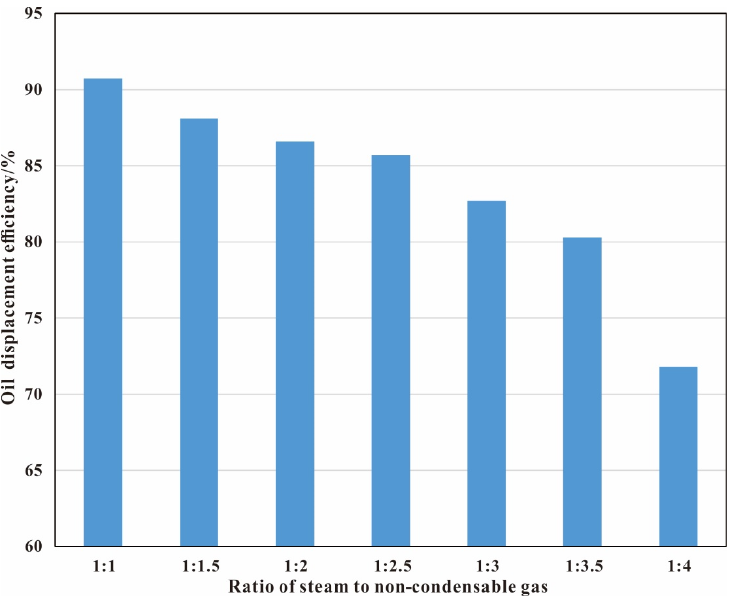
Figure 18. Oil displacement efficiency under different steam/non-condensable gas ratios.